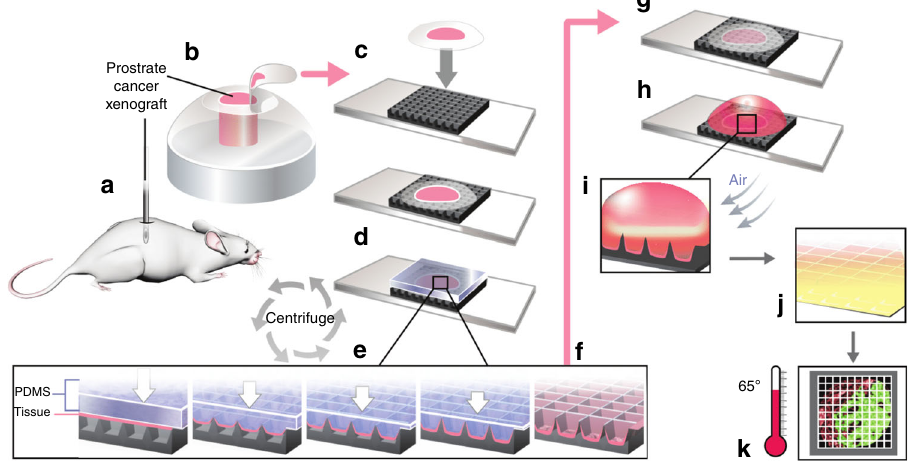
Fig. 1 Overall process fl ow schematic. a LNCaP cells are injected into a mouse and prostate cancer xenograft obtained. b Xenograft is resected and immediately frozen and embedded in optimal cutting temperature compound (OCT). c A 7- µ m tissue cryosection is loaded onto our microchip. d A cured PDMS block is loaded on top of tissue-chip assembly. e , f The PDMS shears and partitions the tissue into small pixels at sharp well edges and pushes them into wells under centripetal force in a standard centrifuge. The pixelated tissue adheres to the silanized (APTES) well surfaces and the PDMS is removed. We call this process “ tissue pixelation ” (time = 2 min). g Post pixelation, the tissue is fi xed with acetone (time = 10 min). A proteinase K digestion is performed after this to create a pathway for ampli fi cation enzymes to reach the target nucleic acids inside the cells (time = 30 min). h RT-LAMP reagents are pipetted on chip in bulk (5 µ L). i Compressed air is blown on it at an angle inside the mineral oil. j Excess reagents are sheared away and only fl uid inside the wells is retained due to capillary forces. In the above steps, picoliter volume RT-LAMP reagents (~175 pL/well) are loaded onto the chip through a rapid instrument-free technique we call “ bulk picoliter reagent loading ” (time = 2 min). k Quantitative gene expression is visualized through real-time imaging of the ampli fi cation reaction in each well performed using only a hot plate at 65 °C and a fl uorescence microscope (time = 45 min). Images